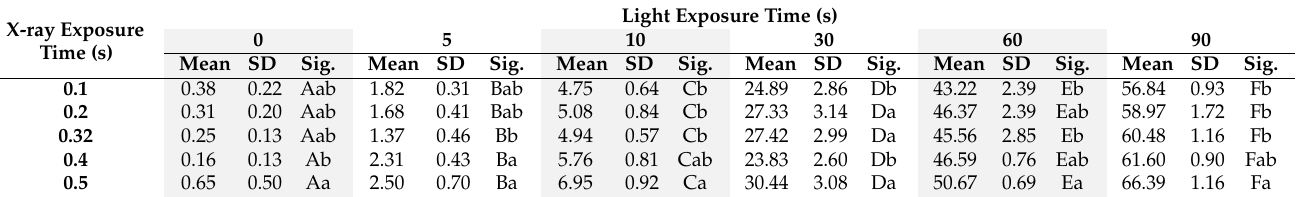
Table 1. Mean values, standard deviation (SD), and pairwise significance (Sig.) of brightness discrepancy as a function of light and X-ray exposure times for the VistaScan